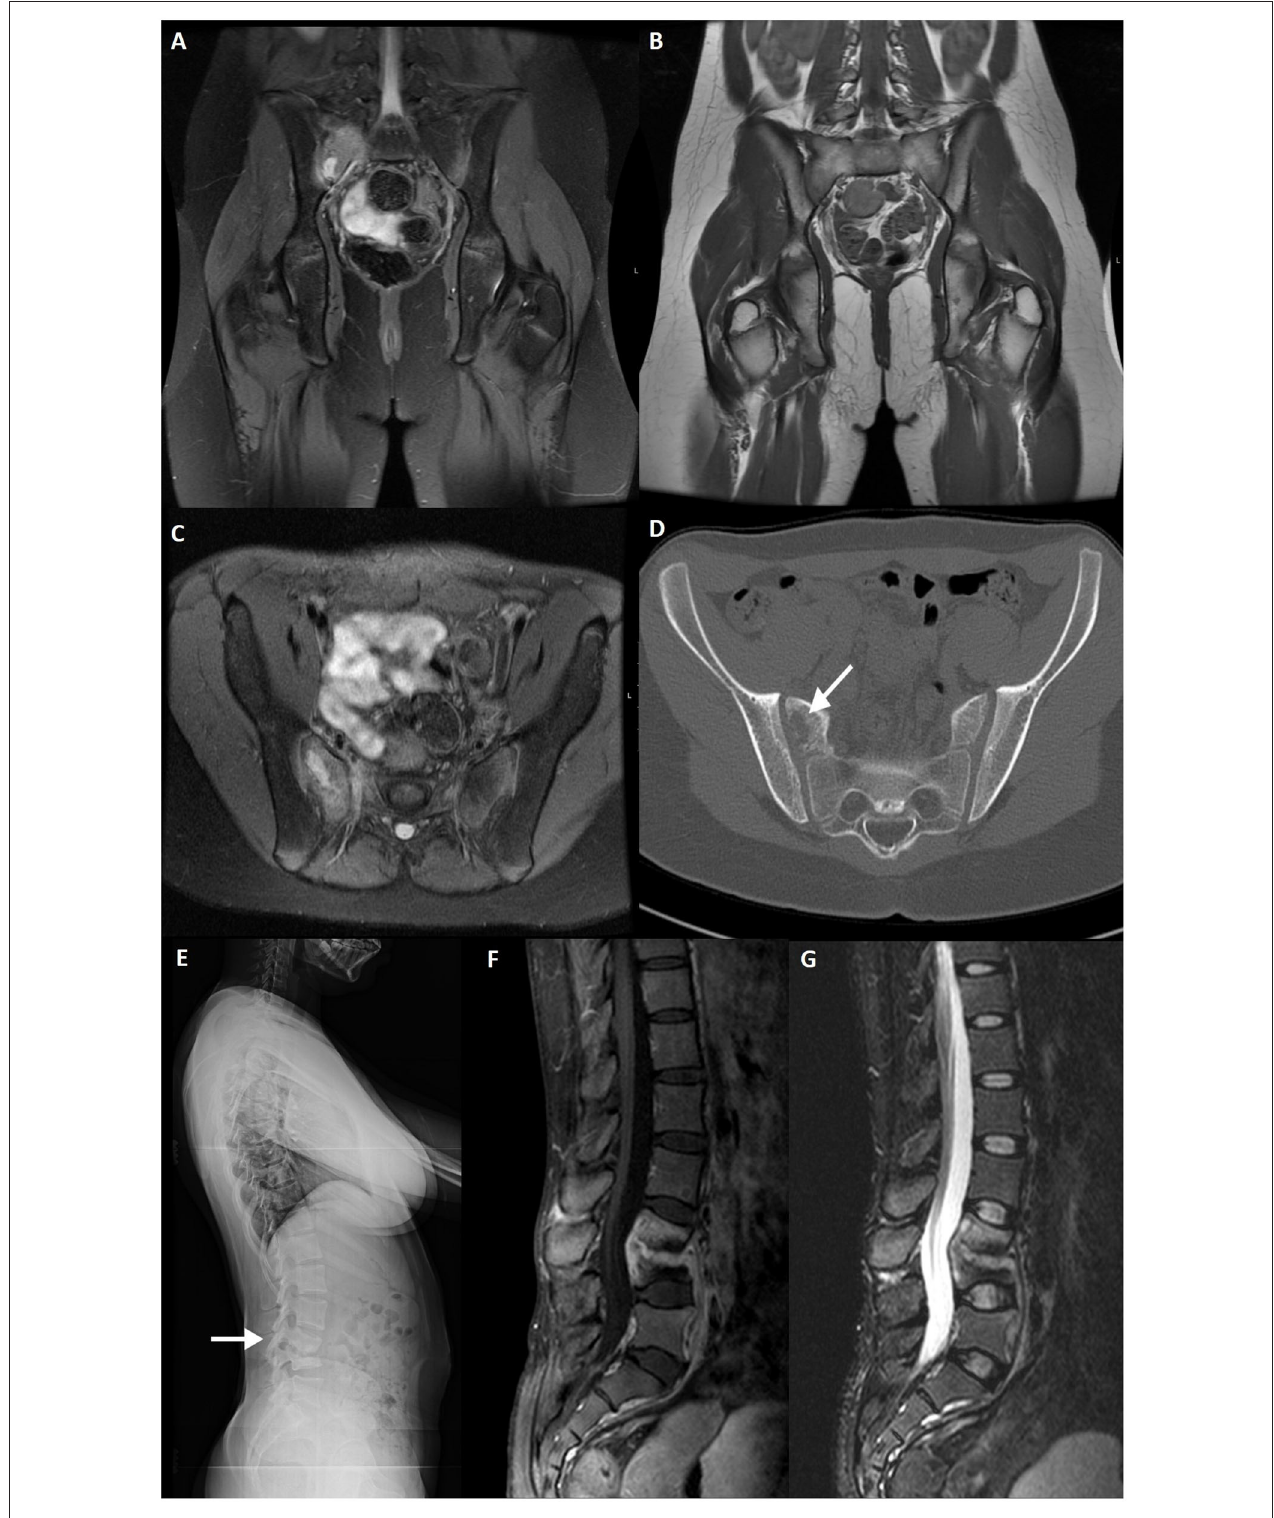
FIGURE 9 | Fat-saturated PD (A) and T1WI (B) coronal slices, fat-saturated PD (C) axial and CT axial slices (D) of a 12-year-old female patient with proven Streptococcus spp. osteomyelitis of the right sacrum (arrow). A lytic lesion is seen adjacent to the right sacroiliac joint. Lateral lumbar radiography (E) , post-contrast fat-saturated T1WI (F) and TIRM (G) sagittal slices of a 26-year-old female patient with confirmed tuberculous spondylodiscitis of L3–L4 segment (arrow).